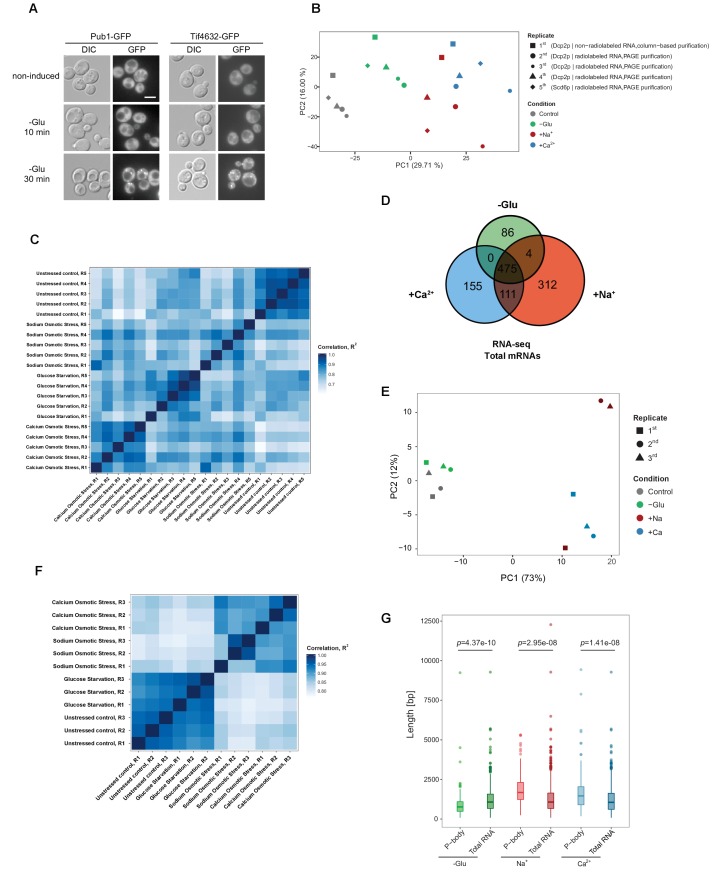
Reproducibility of datasets derived from RNA-Seq and Total RNA-Seq.(A) Stress granules are not induced within 10 min of glucose starvation. Live-cell detection of stress granules (Pub1-GFP and Tif4632-GFP) following glucose depletion. Scale bar, 5 μm. Results are representative of three independent experiments. (B) Principal component analysis (PCA) plot based on the read count profile from aligned P-body associated RNA-Seq data of five biological replicates for each condition. The two first principal components are plotted with the proportion of variance explained, indicated by each component next to the axes labels. (C) Heat map generated from read counts of P-body-associated RNA-Seq datasets by performing pair-wise correlations across replicates and conditions. The continuous scale represents the correlation (R2 value) across samples. (D) Venn diagram illustrating the intersections among upregulated mRNAs (p<0.05) under glucose depletion, Na+ and Ca2+ stresses, relative to the unstressed control as determined by total RNA-Seq. (E) PCA plot based on the read count profile from aligned total RNA-Seq data of three biological replicates for each condition. The two first principal components are plotted with the proportion of variance explained, indicated by each component next to the axes labels. (F) Heat map generated from read counts of total RNA-Seq datasets by performing pair-wise correlations across replicates and conditions. The continuous scale represents the correlation (R2 value) across samples. (G) Length (total exonic) comparison of P-body-associated and total upregulated mRNAs under indicated stresses. A non-parametric, two-sided Wilcoxon test was used to determine p values.